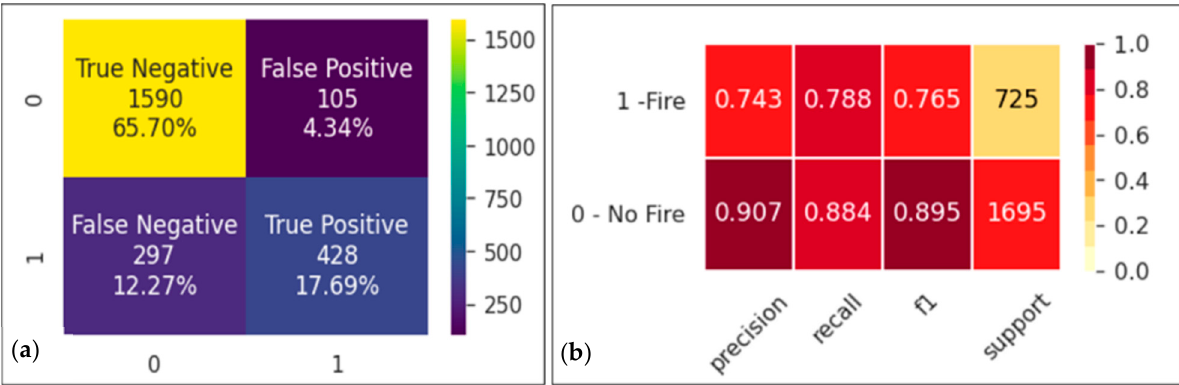
Figure 8. Confusion Matrix ( a ) and Classification report ( b ) of for Ensemble (Adaboost) model.